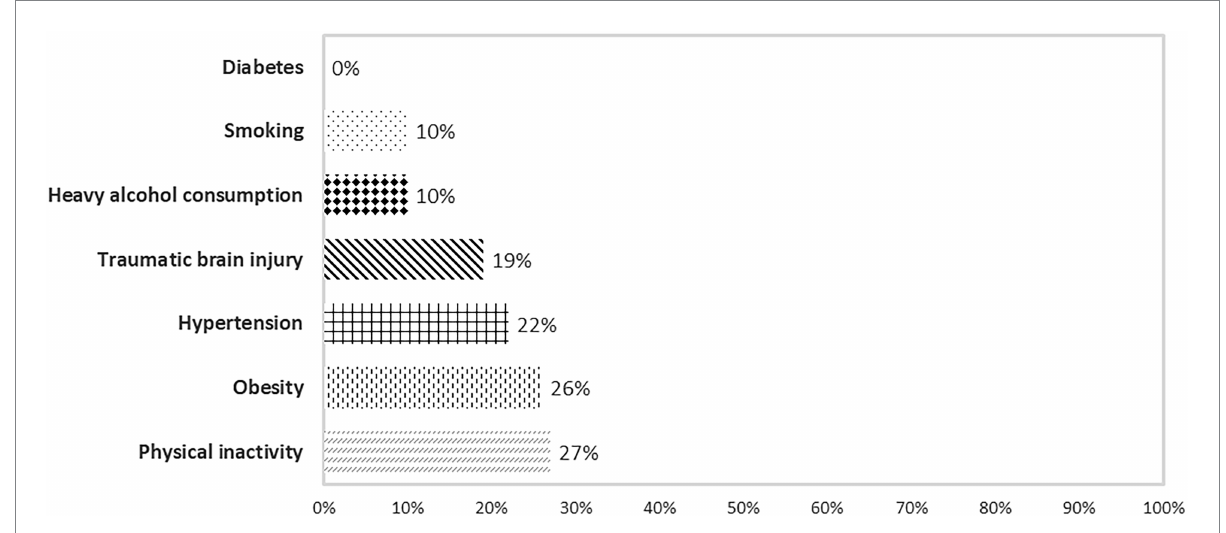
FIGURE 4 Prevalence of cognition-associated risk factors related to habits and medical and psychological condition reported by participants.